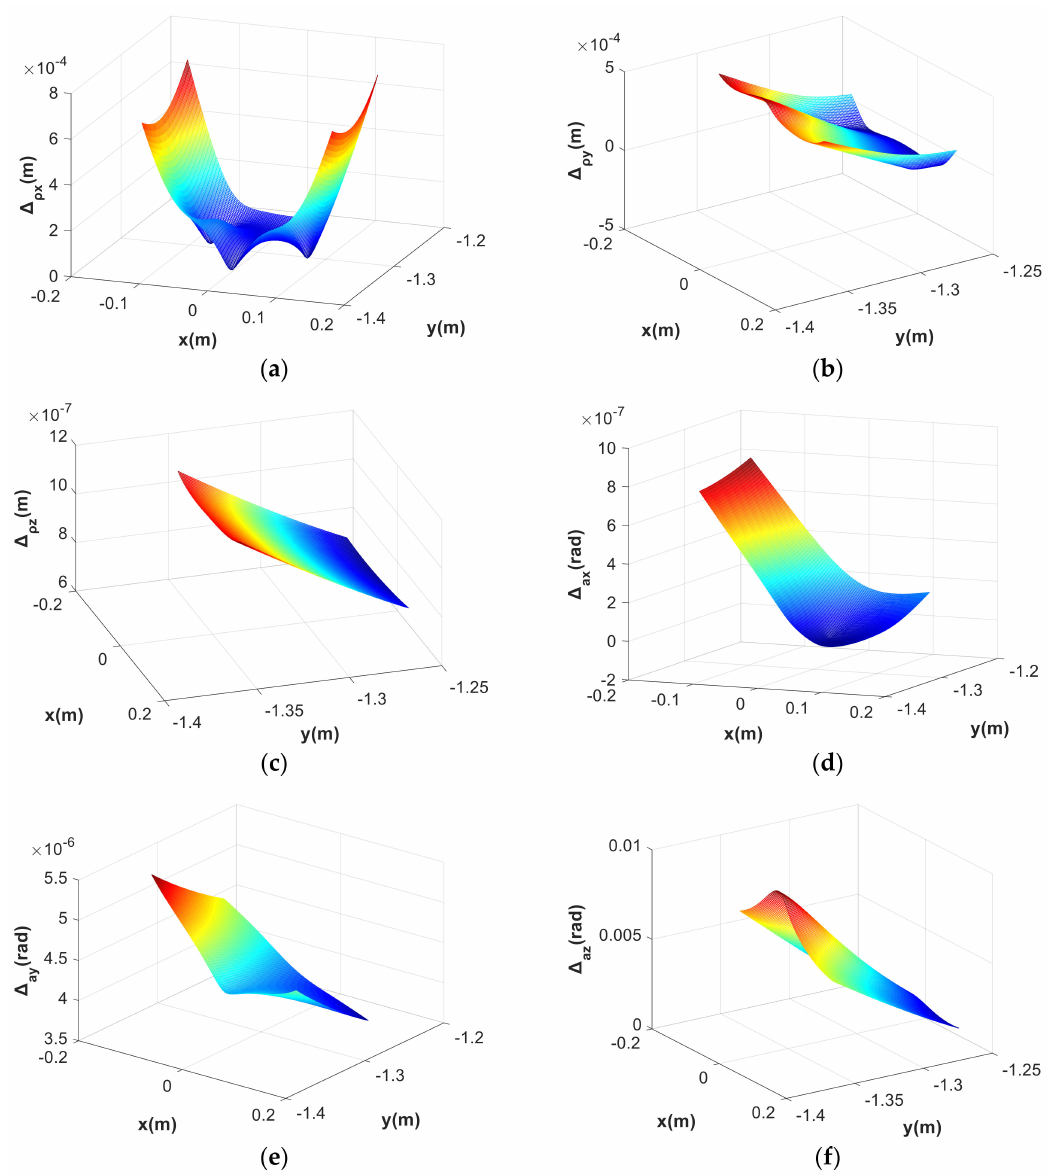
Figure 10. Deformation distributions of the mechanism in the sub-workspace of type II. ( a ) Linear deformation distribution in x direction of type II; ( b ) Linear deformation distribution in y direction of type II; ( c ) Linear deformation distribution in z direction of type II; ( d ) Angular deformation distribution in x direction of type II; ( e ) Angular deformation distribution in y direction of type II; ( f ) Angular deformation distribution in z direction of type